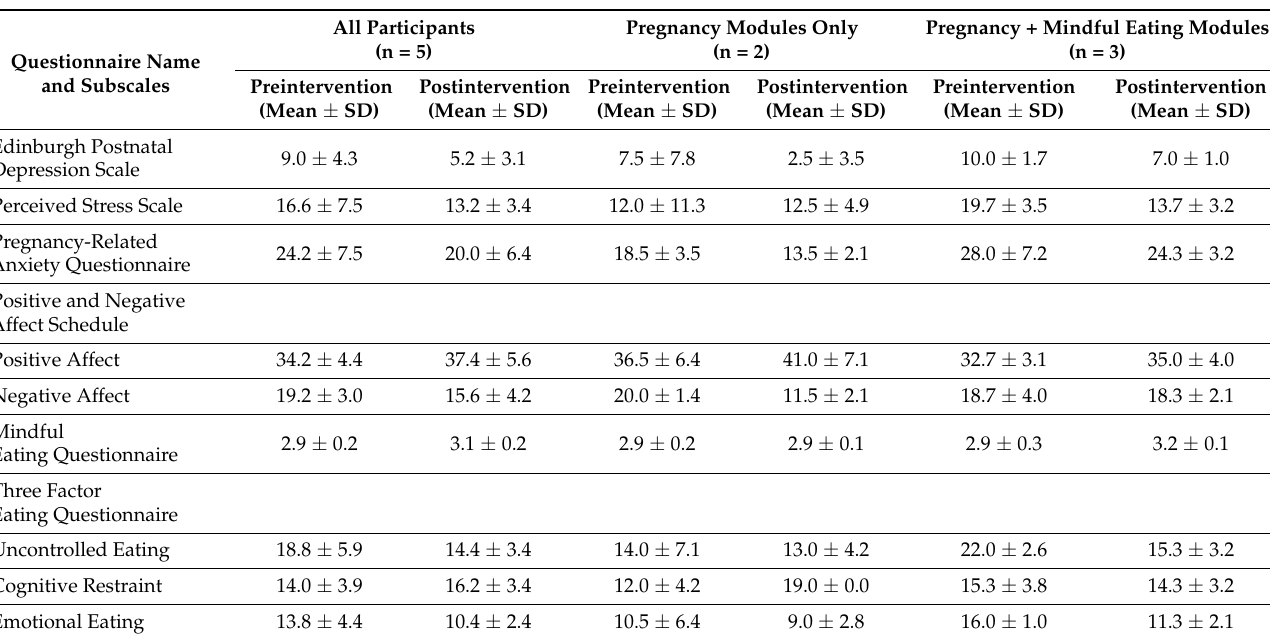
Table 2. Pre- and postintervention questionnaire scores for all participants and stratified by modules